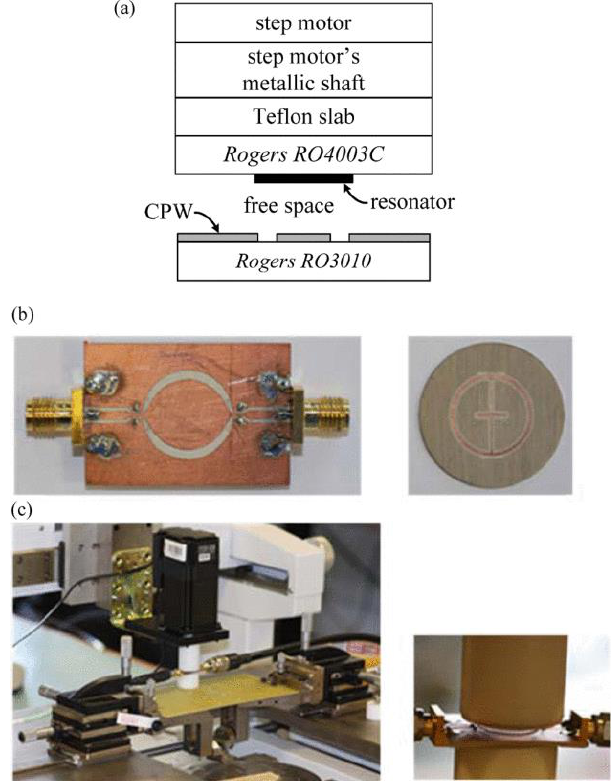
Figure 13. Set-up for the angular displacement and velocity measurement. ( a ) Cross section view, ( b ) photographs of the rotor (circular ELC resonator) and stator (CPW), and ( c ) photograph of the step-motor providing rotor motion and zoom view of the stator-rotor. From [22], reprinted with permission.